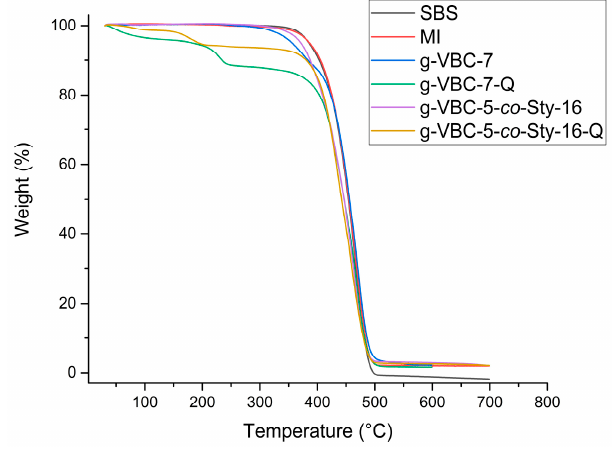
Figure 6. TGA traces of SBS, MI, g-VBC-7, g-VBC-7-Q, g-VBC-5- co -Sty-16, and g-VBC-5- co -Sty-16-Q. Table 2. Thermogravimetric data of the grafted copolymers before and after quaternization reaction, the corresponding macroinitiator, and SBS.